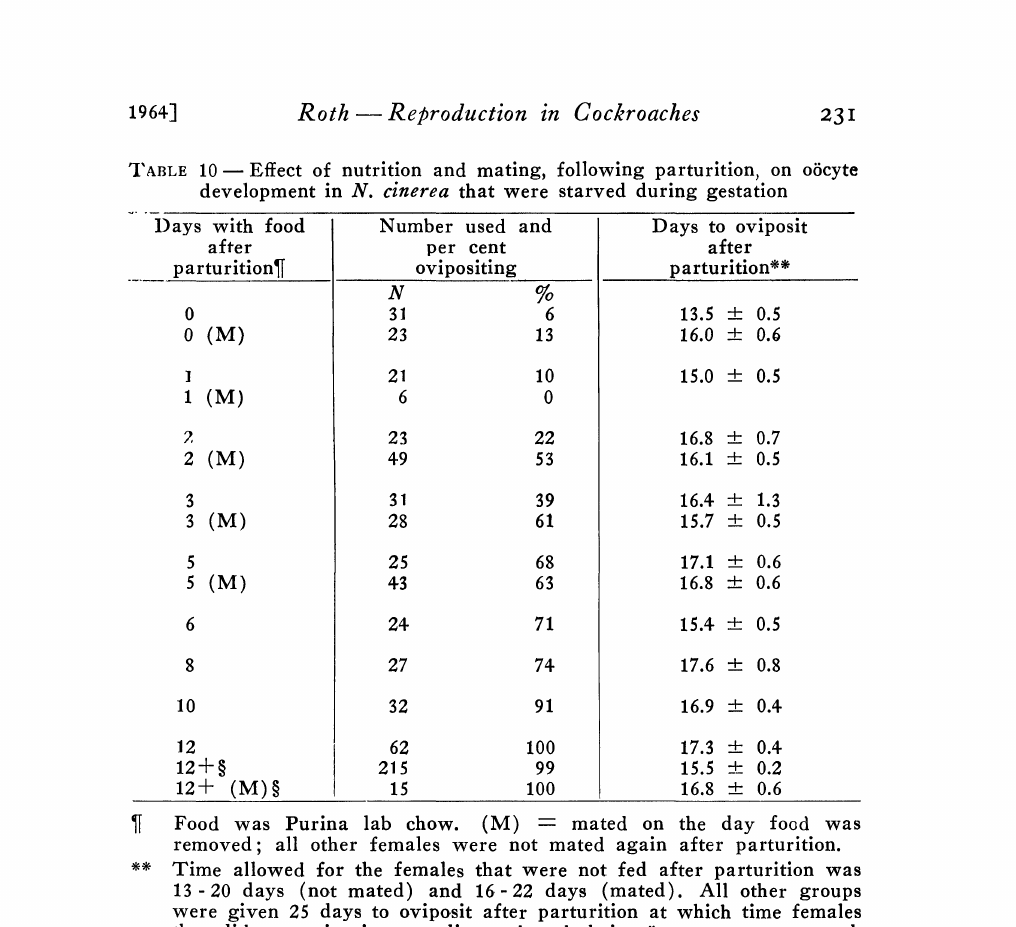
"tABLE 10--Effect of nutrition and mating, following parturition, on oScyte development in N. cinerea that were starved during gestation -)ays with food